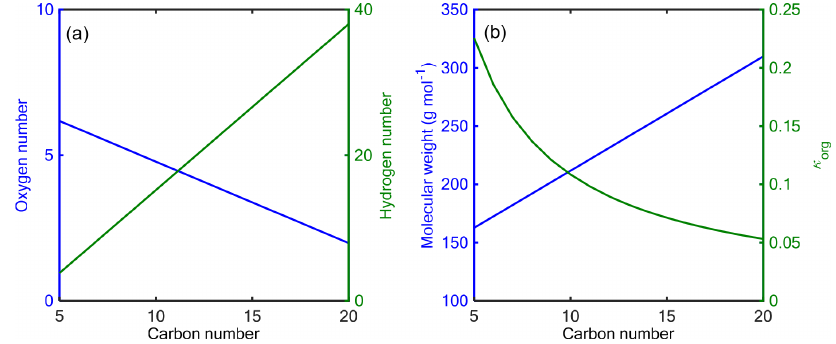
Figure 4. Oxygen and hydrogen numbers (a) and molecular weight and κ org (b) as functions of carbon number for secondary organic species with a volatility C ∗ of 0.1µgm − 3 (i.e., log 10 C ∗ = − 1).